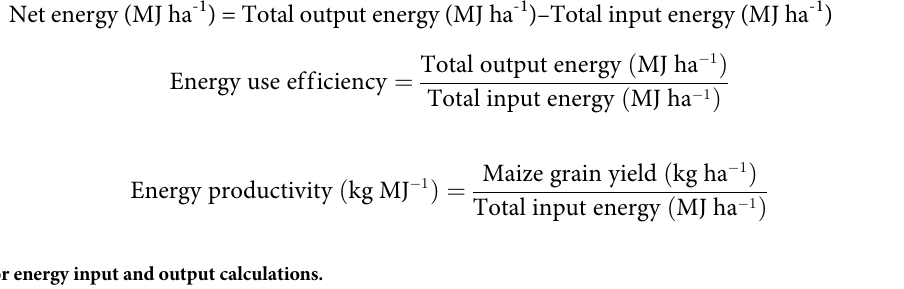
Table 1. Energy equivalents (MJ unit -1 ) were used for energy input and output calculations. Particulars Unit Energy